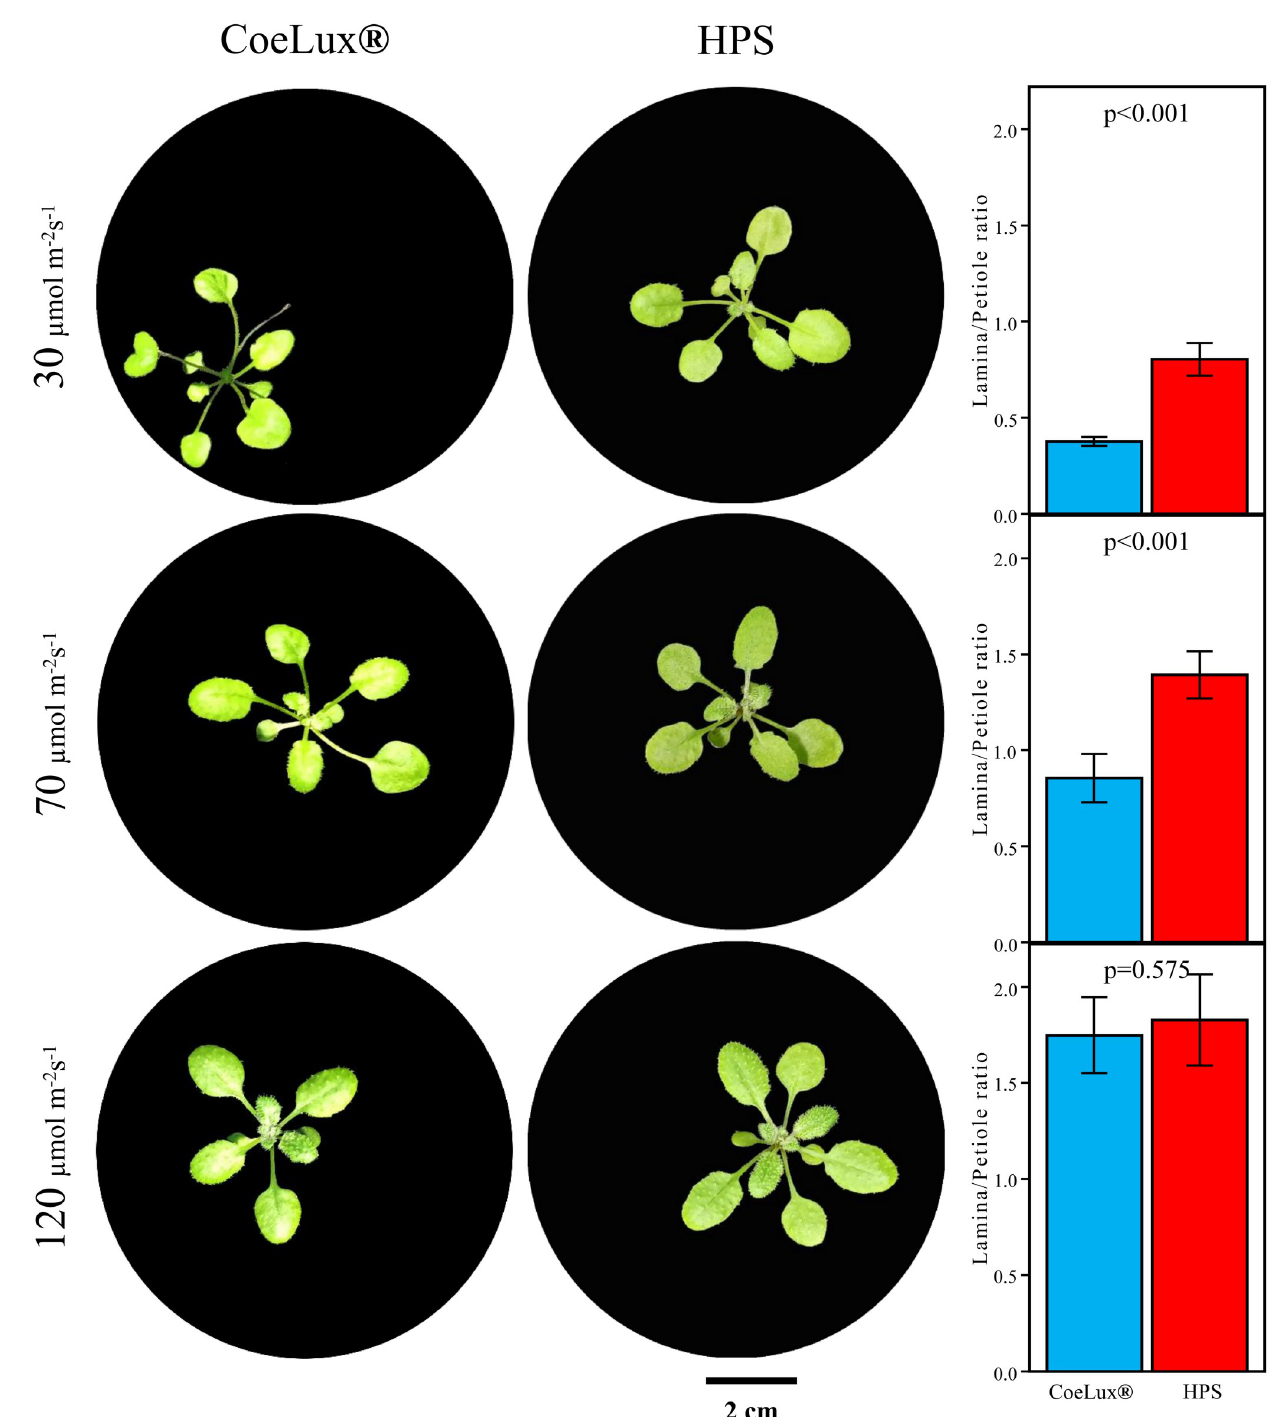
Fig 3. A . thaliana morphology in response to light treatments. Comparison of representative rosette phenotypes of plants at the 6-leaf phenological stage grown with constant light cycle (14:10) under the indicated light treatments. Data represent the means of n = 12 biological repeats ± 95% CI.